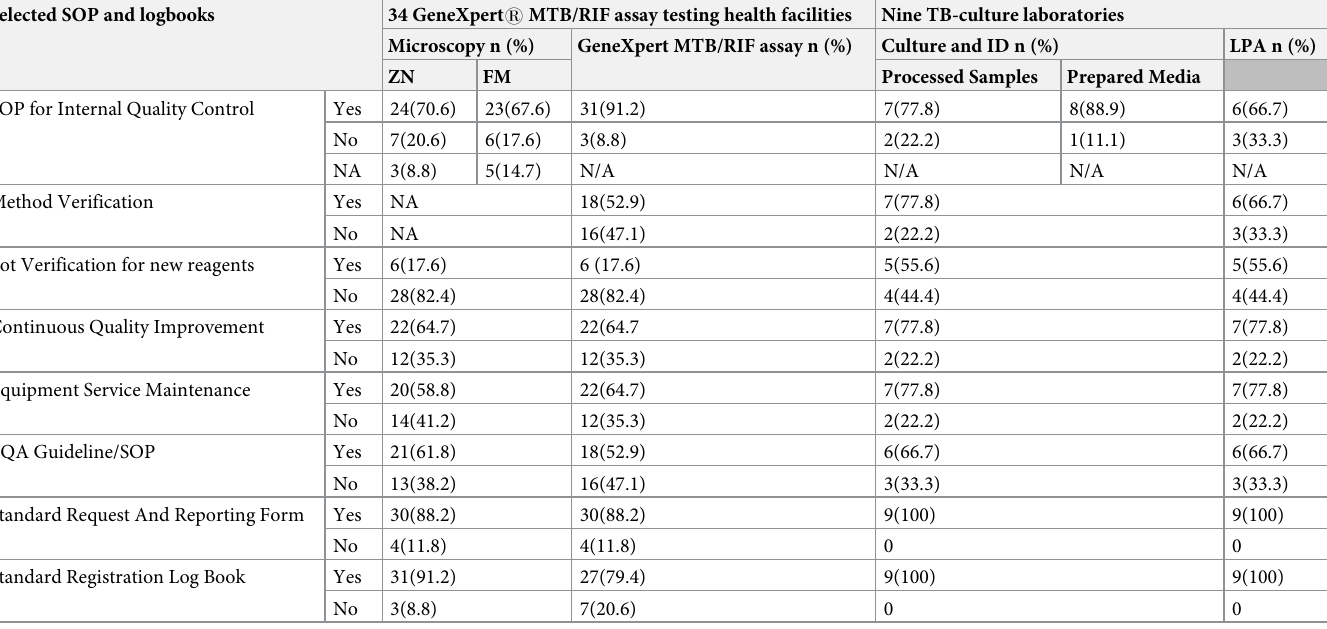
Table 2. SOP available for TB diagnostic tests among 34 Xpert testing health facilities and nine TB-culture laboratories in Ethiopia. Selected SOP and